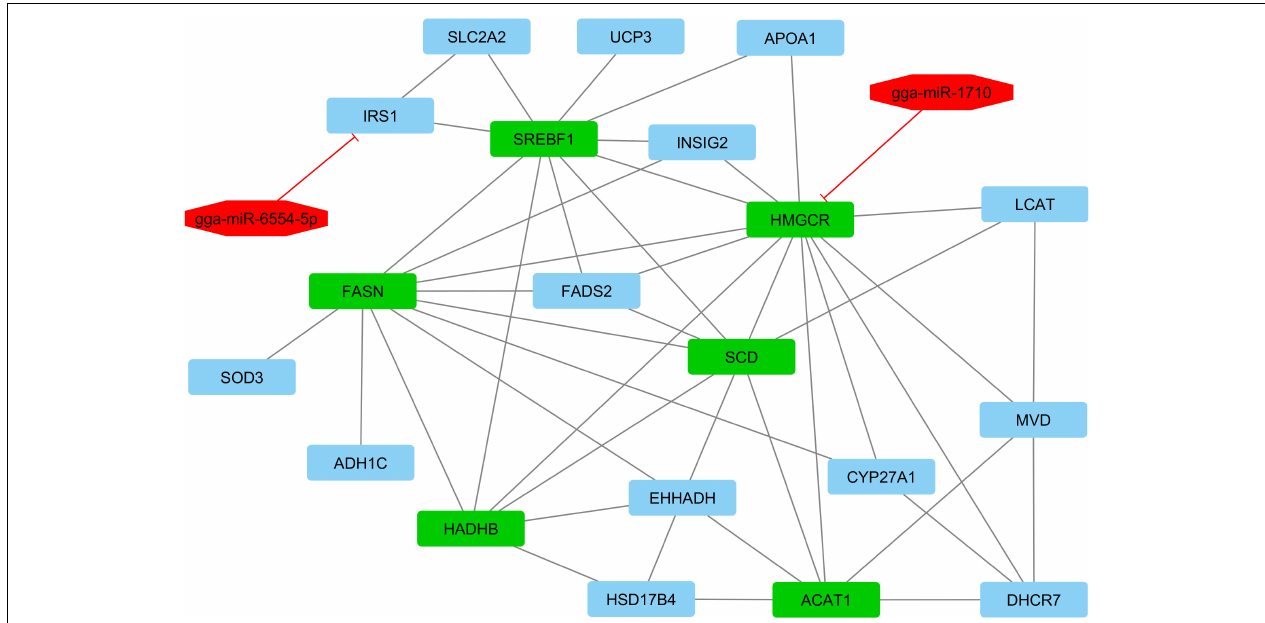
FIGURE 4 | Module 1: 20 genes and two miRNAs in the interactive bipartite network of gene–miRNA. In this network, the quadrilateral points represent the genes, and the octagonal points represent miRNAs. In this interactive bipartite network, the gene–miRNAs of quadrilateral nodes represent genes and octagonal nodes represent miRNAs. For miRNAs and target genes, the edges indicate the suppressing roles of miRNAs. The edges of genes also indicate the gene–gene interactions. The green quadrilateral nodes represent the hub genes. Purple quadrilateral nodes have the highest rates of suppression by